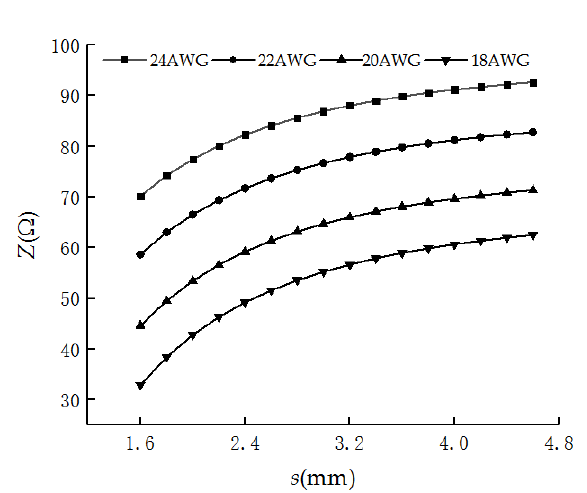
Figure 5. The calculated distribution capacitance C and inductance L of 22AWG PHSC.